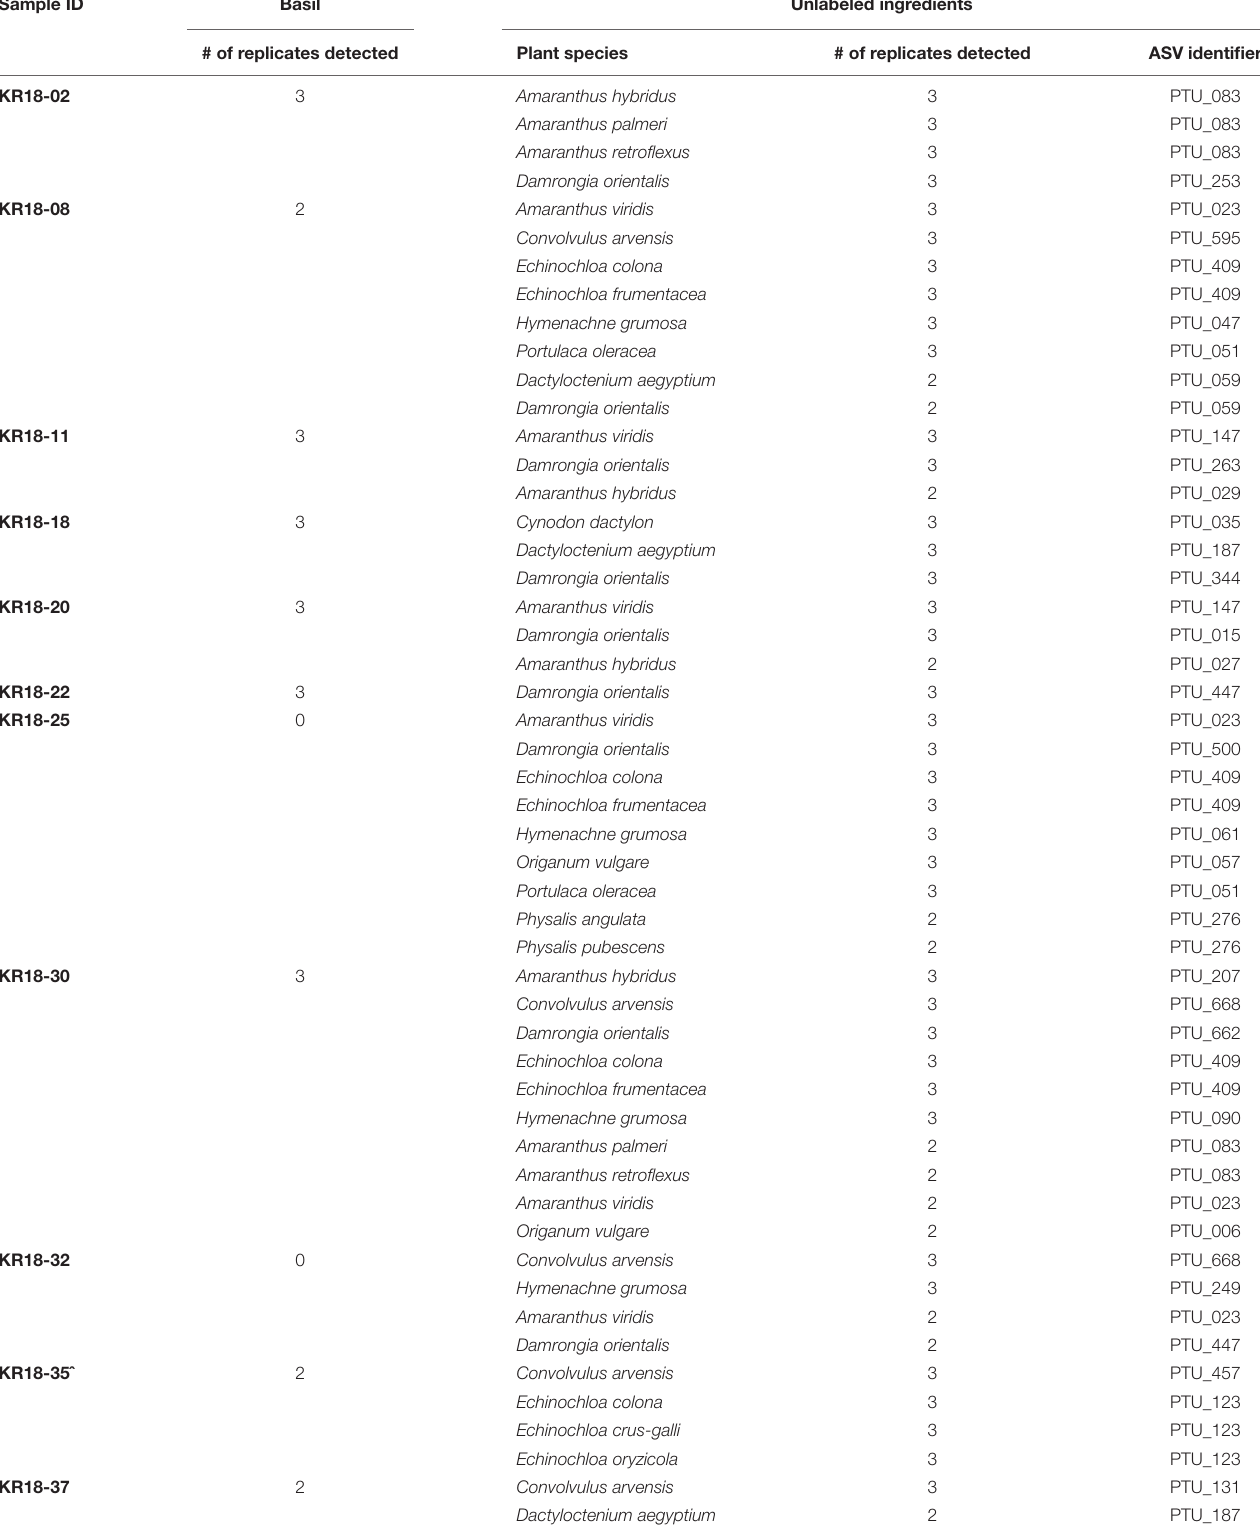
TABLE 3 | DNA metabarcoding based authentication of the products labeled as containing basil. Sample